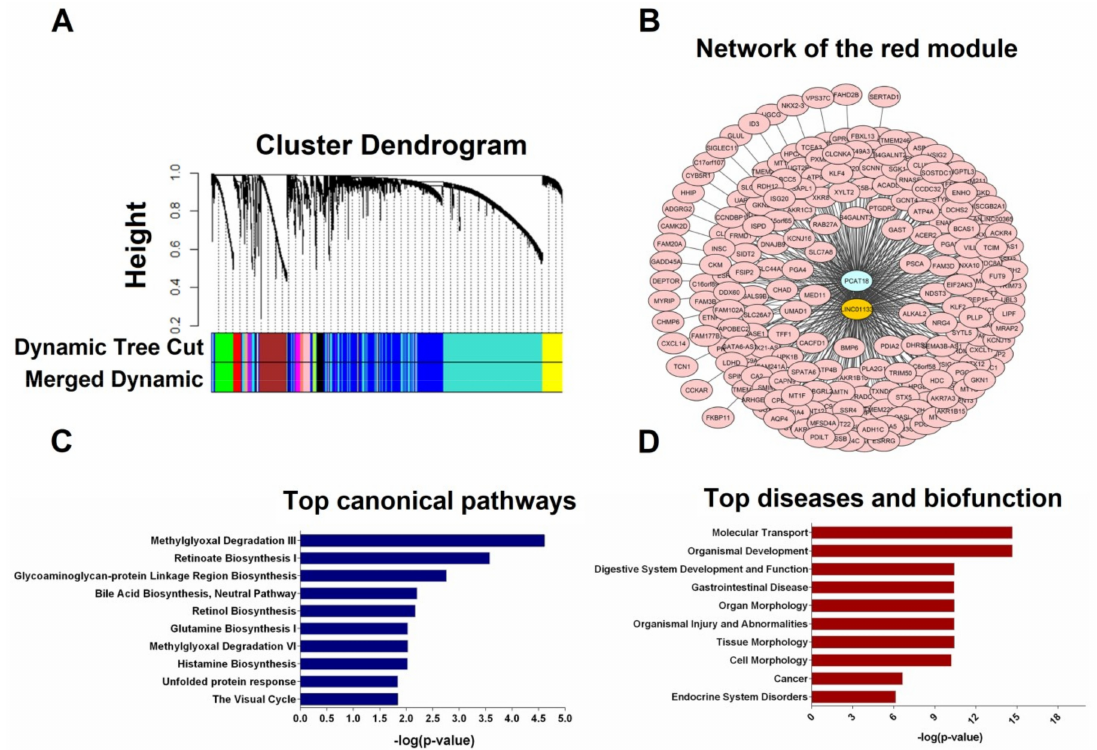
Figure 5. Weighted gene correlation network analysis (WGCNA) and pathway analysis using RNA-sequencing (RNA-seq) data from the TCGA stomach cancer dataset. ( A ) WGCNA cluster dendrogram of differentially expressed mRNAs and lncRNAs. Each leaf (vertical line) in the dendrogram corresponds to a gene. The color row underneath the dendrogram shows the assigned original module and the merged module. The lncRNA candidates PCAT18 and LINC01133 were clustered in the red module; ( B ) The lncRNA-mRNA network of the red module visualized using the cytoscape software platform; ( C ) Over-represented terms in the Molecular and Cellular Function category; ( D ) Top diseases and biofunctions related to co-expressed